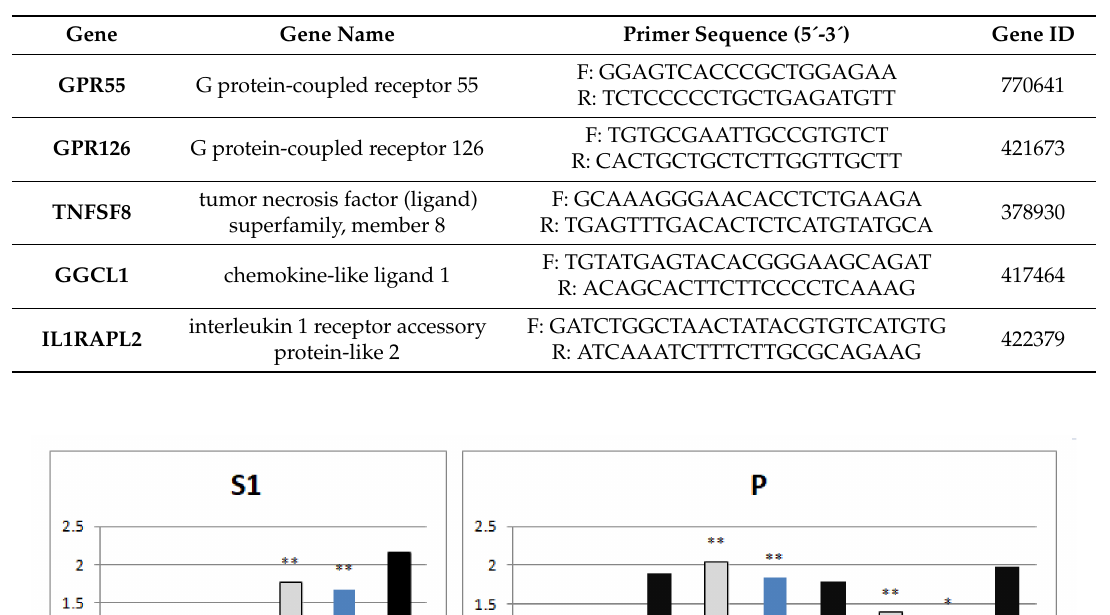
Table 3. Gene panel selected for validation of the microarray experiment using the RT-qPCR method. Gene selection was done based on the microarray